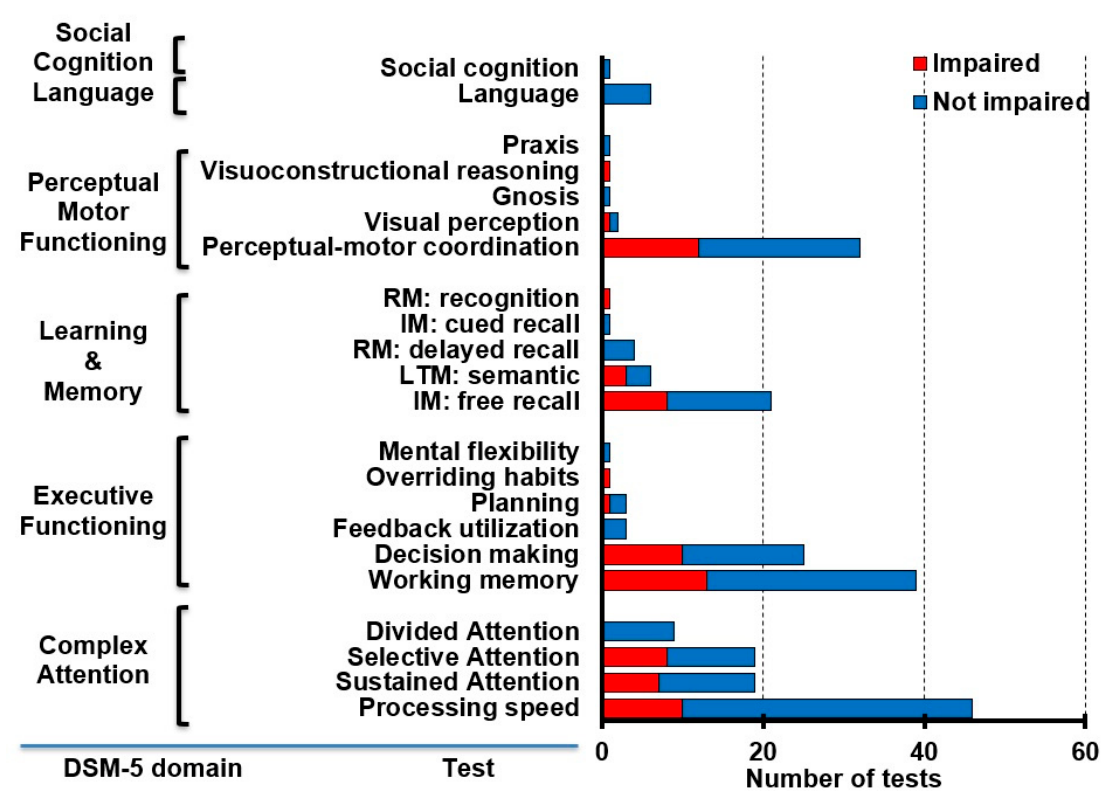
Figure 1. Frequency of impairment during hangover in DSM-5 neurocognitive subdomains. Abbreviations: DSM = Diagnostic and Statistical Manual of Mental Disorders, RM = recall memory, IM = immediate memory, LTM = long term